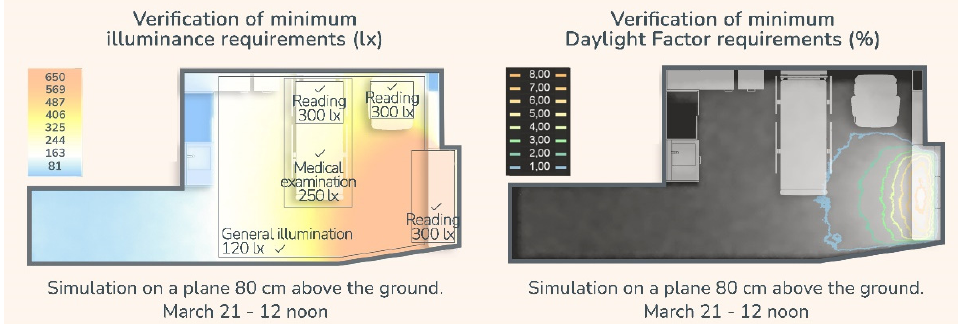
Figure 11. Verification of minimum illuminance (lx) and daylight factor (%) requirements on post operam.